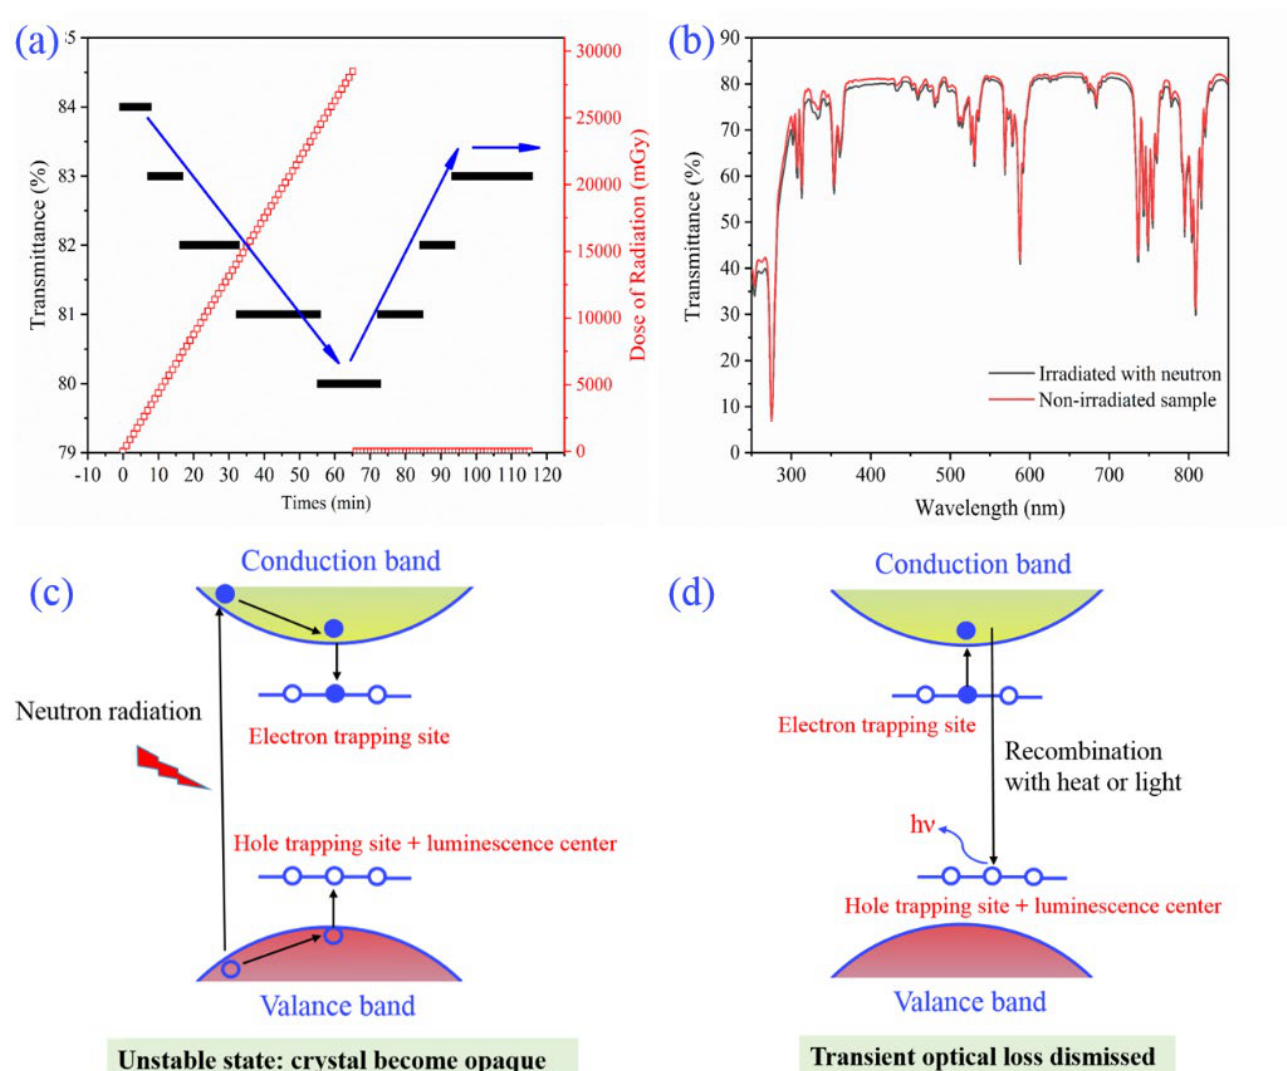
Figure 2. ( a ) The in-situ and real-time transmittance of Nd:GSAG crystal varies with the fluctuation of neutron irradiation dose. ( b ) The transmission spectrum of Nd:GSAG crystal before and after irradiation with 2.85 kGy doses of neutron. ( c ) Schematic representation of the trapping processes of electrons and holes with neutron radiation. ( d ) Schematic representation of the recombination processes of electrons and holes.